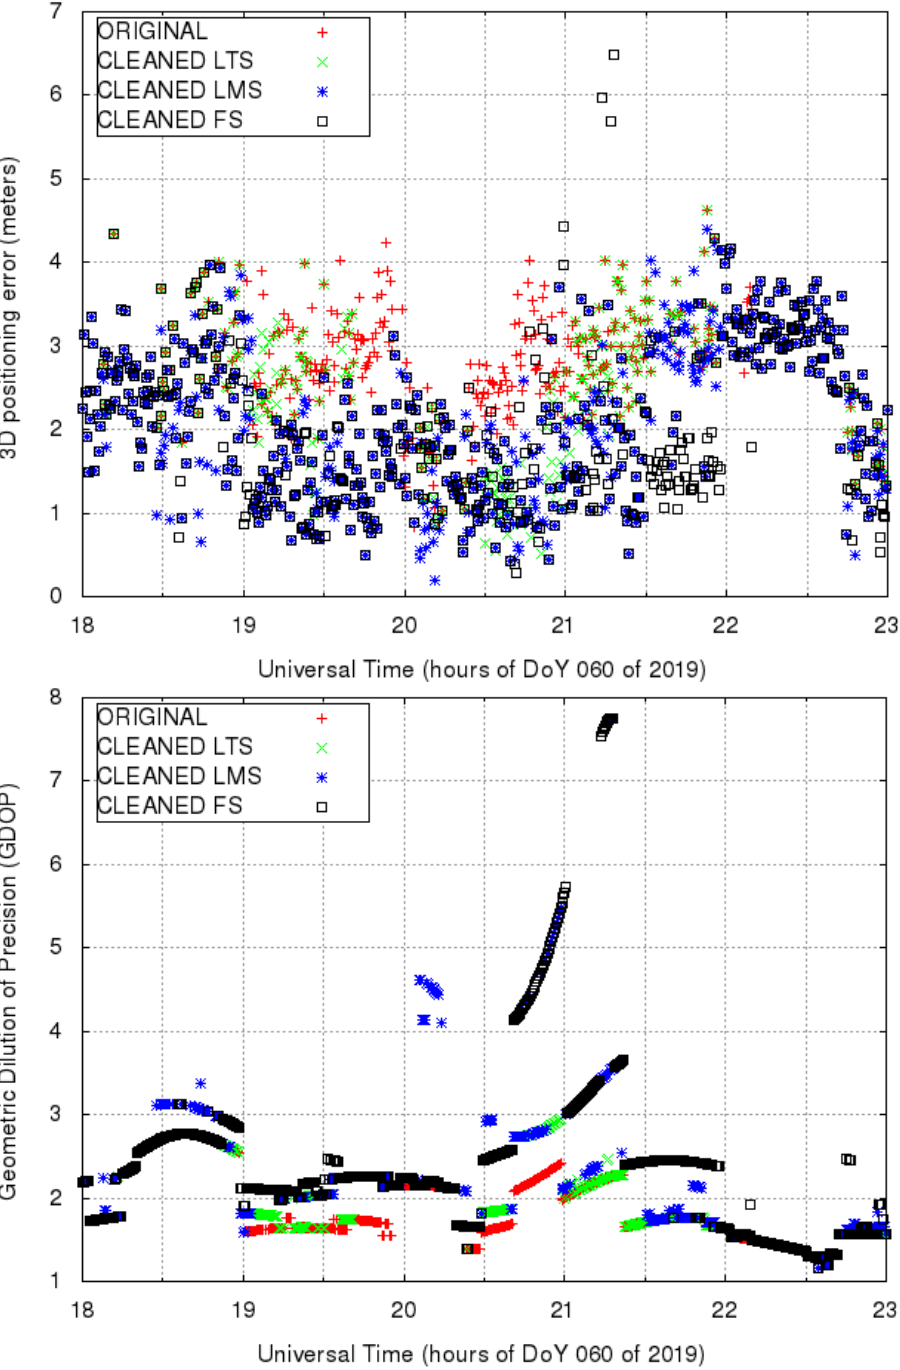
Figure 9. Zoom of Figure 8 for the time period comprised between 18 and 23 h. The top plot depicts the 3D position errors, whereas the bottom plot the